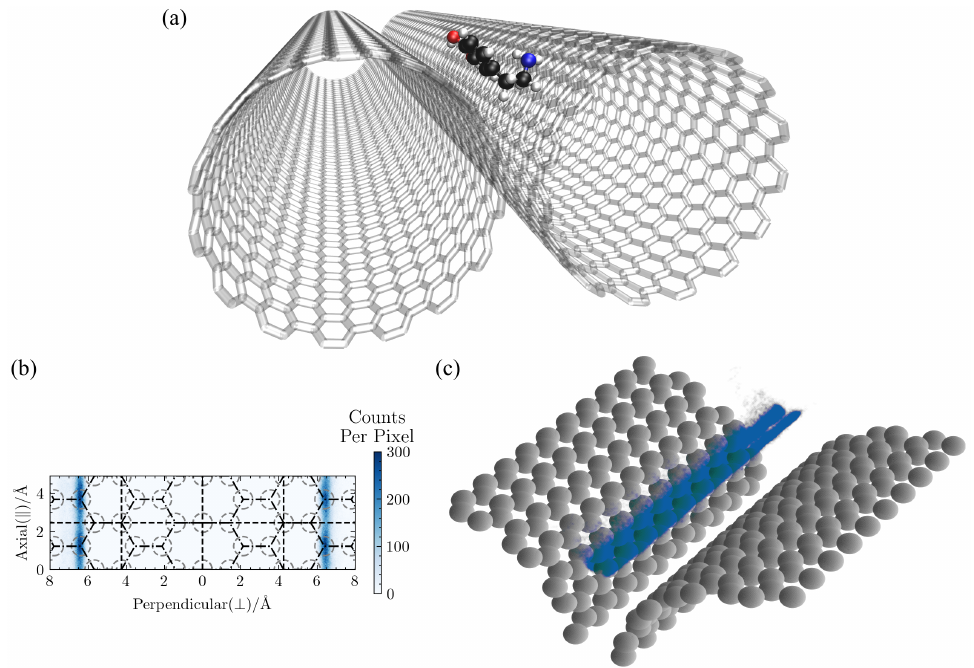
Figure 12. Spatial distributions of DA in a solvated CNT groove. The COM coordinates of DA within a solvated CNT groove formed by two parallel CNT, as seen in a typical configuration shown in ( a ), are plotted here in both ( b ) 2D and ( c ) 3D. The CNT groove is constructed of two parallel, 100 Å ( 15,15 ) -CNTs. In the 2D distribution plot in ( b ), locations along the axial direction were wrapped into two unit cells. The gray dashed circles represent the location of the surface carbon atoms, and the black dashed line in the middle at ⊥ = 0 Å represents the location on the CNT circumference where the distance between the two CNTs is smallest. The distribution density in region to the left of that dashed line results from configurations where the adsorbate is closest to the CNT on the left, while the density to the right results from configurations where the adsorbate is closest to the CNT on the right. In the 3D distribution in ( c ), the COM coordinates along the axial direction were wrapped into ten unit cells for plotting.